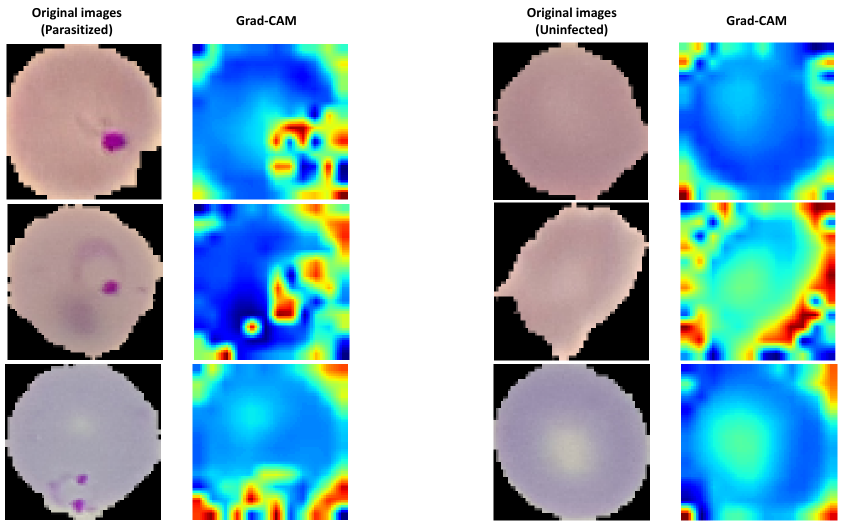
Figure 10. Process of the Grad-CAM algorithm for the original image via the AutoKeras model.